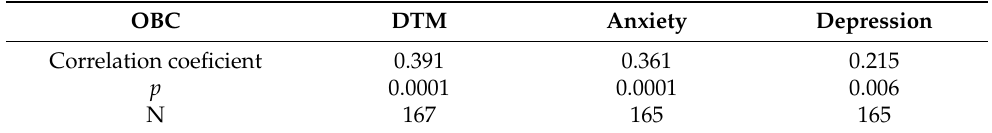
Table 9. Spearman correlation between OBs and TMD, anxiety, and